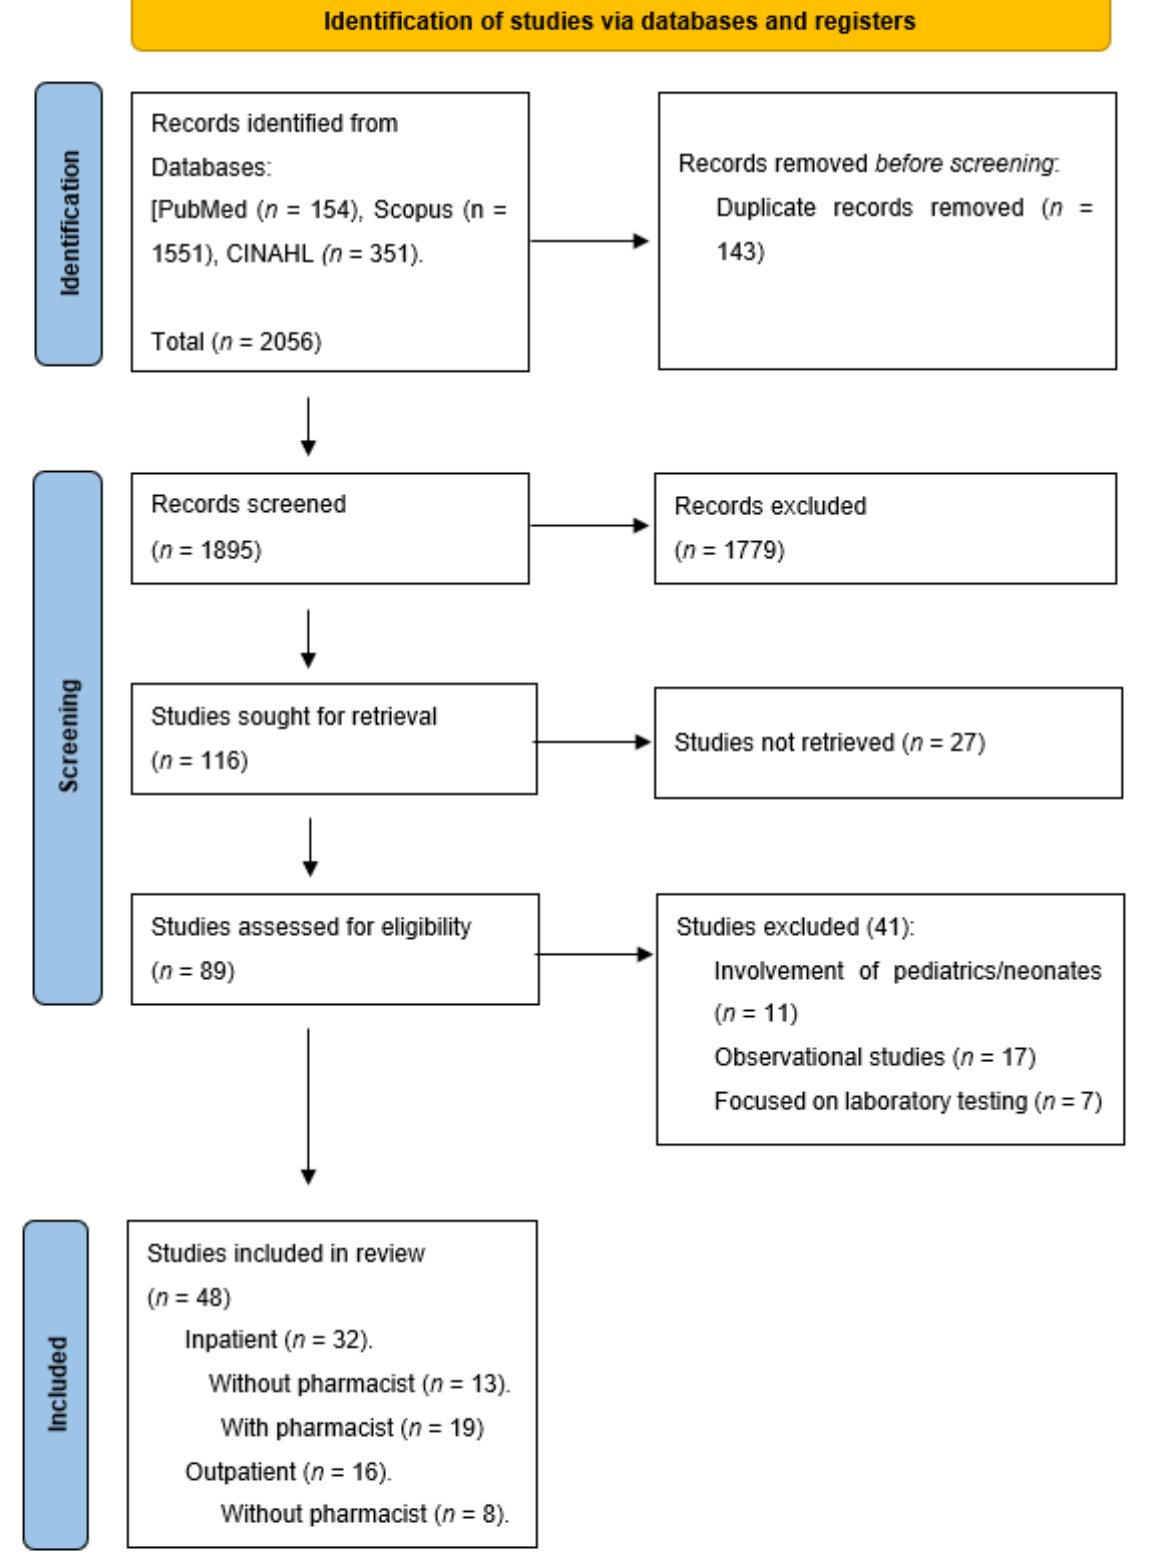
Figure 1. PRISMA flow diagram of the process of study selection.